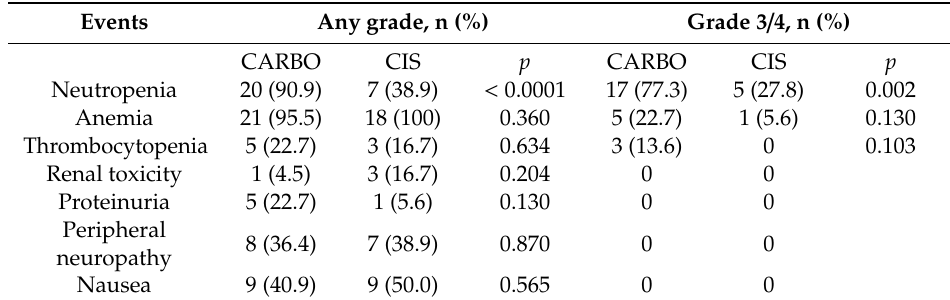
Table 2. Adverse events the patients with FIGO IIIC serous type epithelial tubo-ovarian cancer, or primary peritoneal carcinoma treated with weekly paclitaxel (80 mg/m 2 ) plus either carboplatin (AUC 5) or cisplatin (20mg/m 2 ) combination chemotherapy triweekly.